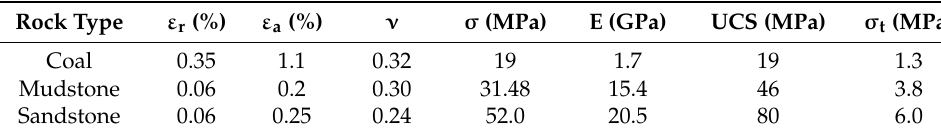
Figure 6. Stress–strain curve of rock specimens. Table 1. Experimental result of unconfined compression tests.